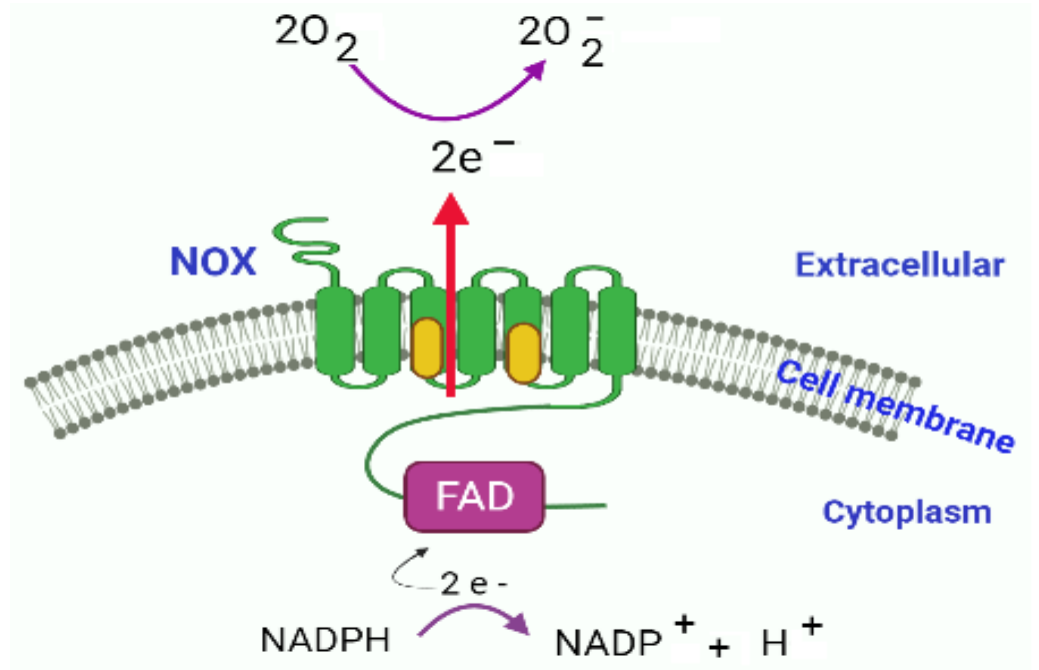
Figure 5. NOX electron transport system comprising of NOX transmembrane domains associated with heme molecules (indicated as yellow) at domain 3 and 5, C terminal region containing FAD and NADPH binding sites, transfer of electrons is catalysed by NOX. The transport of electrons results in the production of superoxide ion O 2 − .